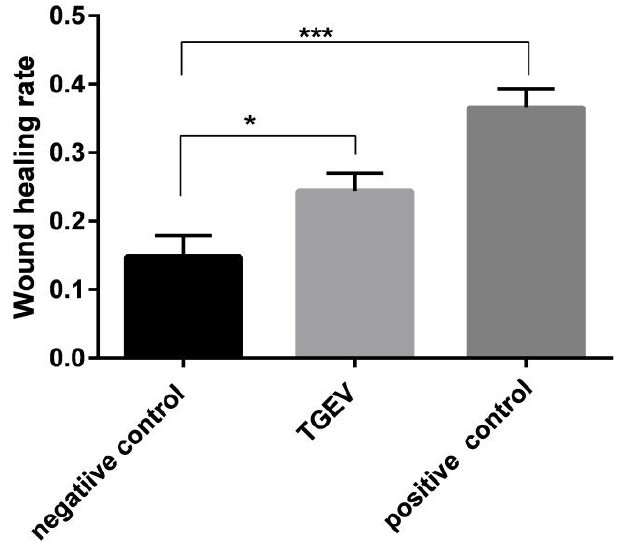
Figure 5. Effects of TGEV infection on cell width. ( a ) Control group; ( b ) TGEV group; ( c ) TGF- β group.